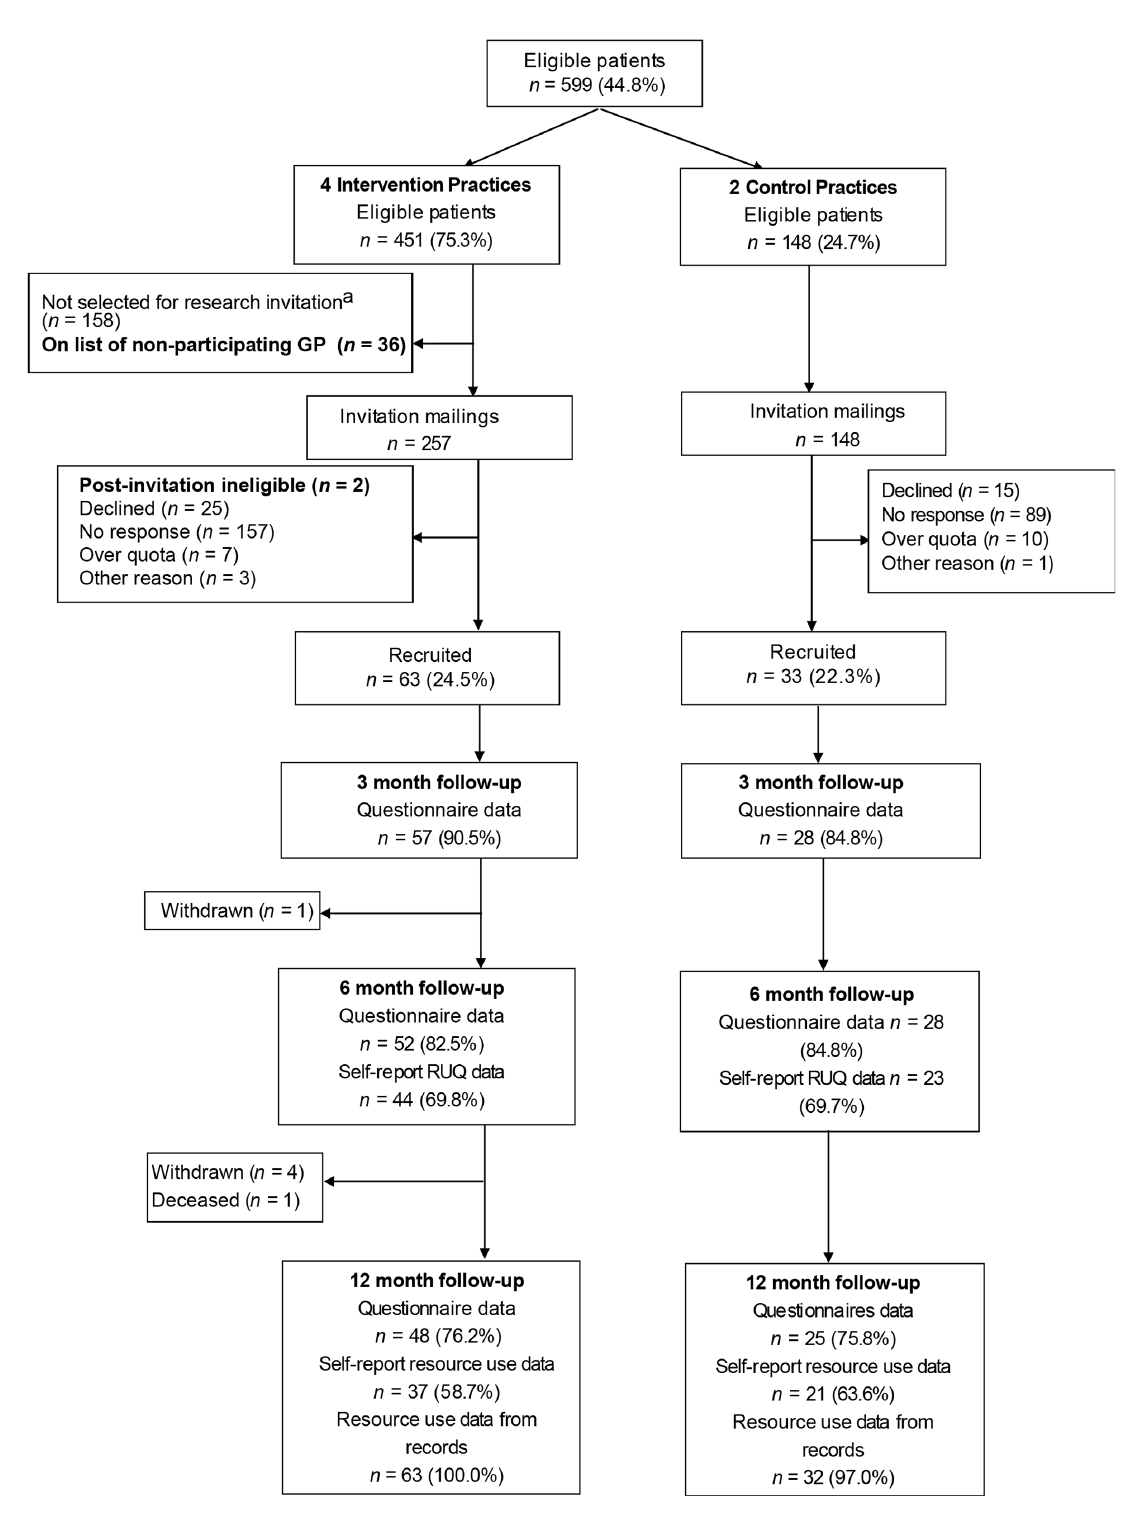
Figure 2 CONSORT flowchart: questionnaire study. a In the larger practices, study invitations were only sent to half the eligible patients in order to avoid over-recruitment. RUQ = resource use